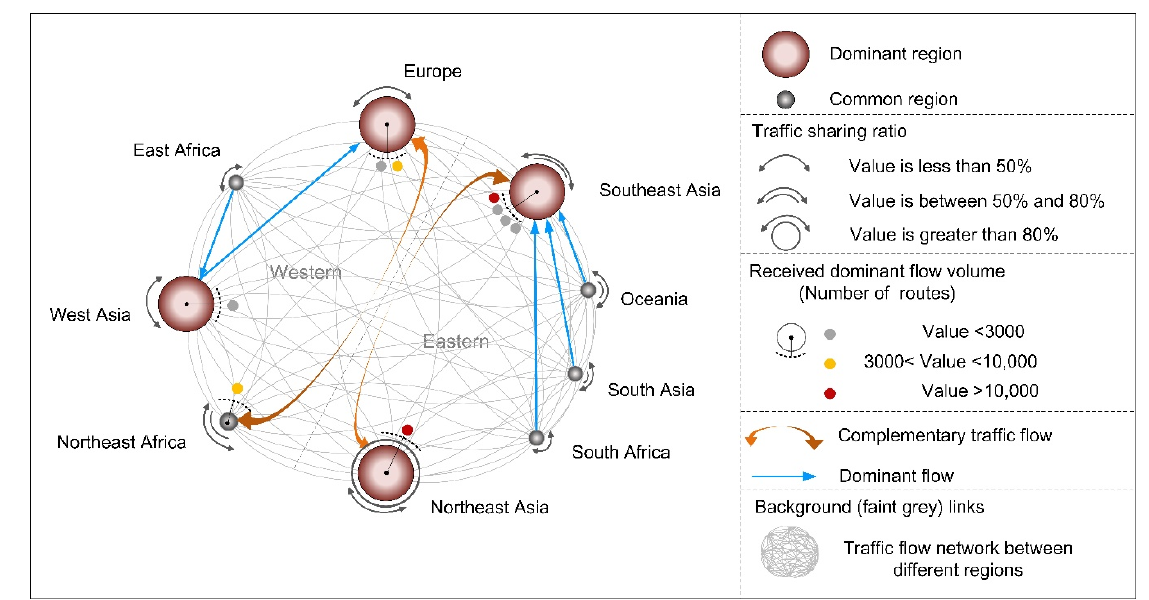
Figure 7. Primary linkage analysis. On the basis of traffic flow network between different regions, further analyze the direction and volume of the dominant flows, in order to explore the status and relations of each region.